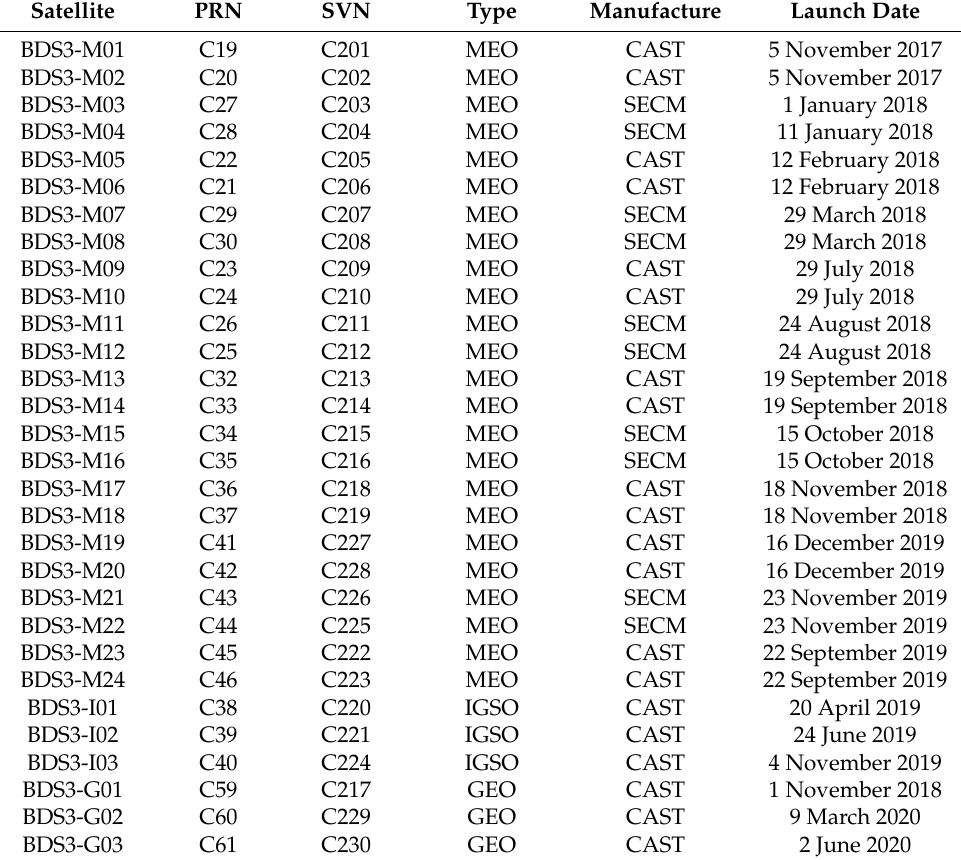
Table 1. Operational status of the BDS-3 constellation as of October